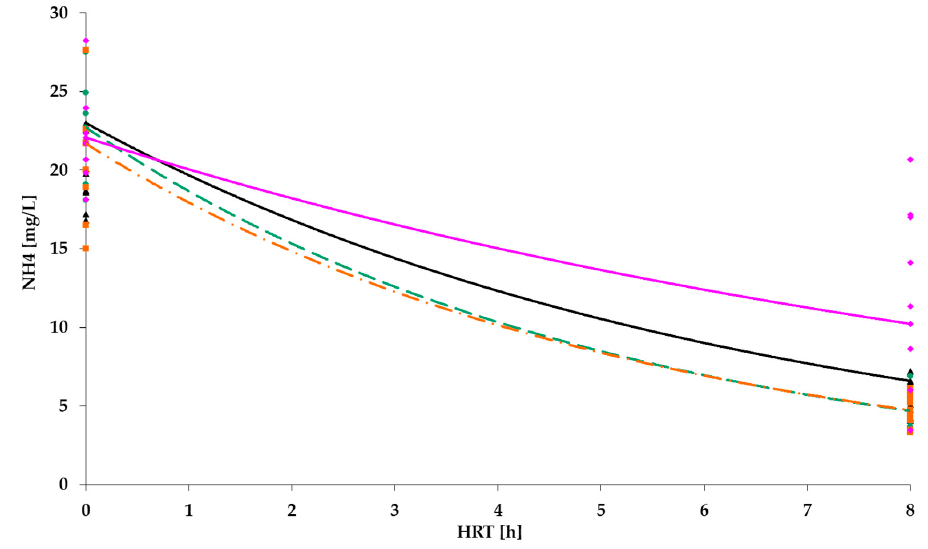
Figure 13. Ammonium removal dynamics if: floating carrier BB is 10% of reactor volume (black); 20% of tank volume (green); 30% of tank volume (orange); no carrier in the reactor (magenta). Table 4. Average values of treatment for BB-carrier.